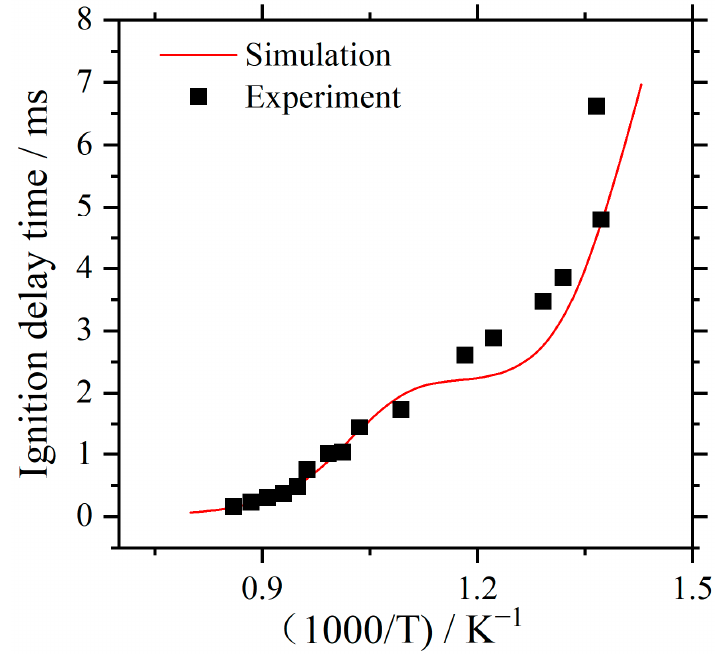
Figure 3. Validation of the chemical reaction mechanism of gasoline.